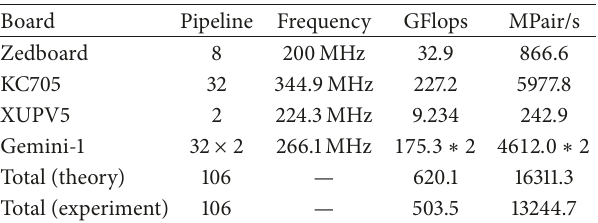
Table 4: The number of potential